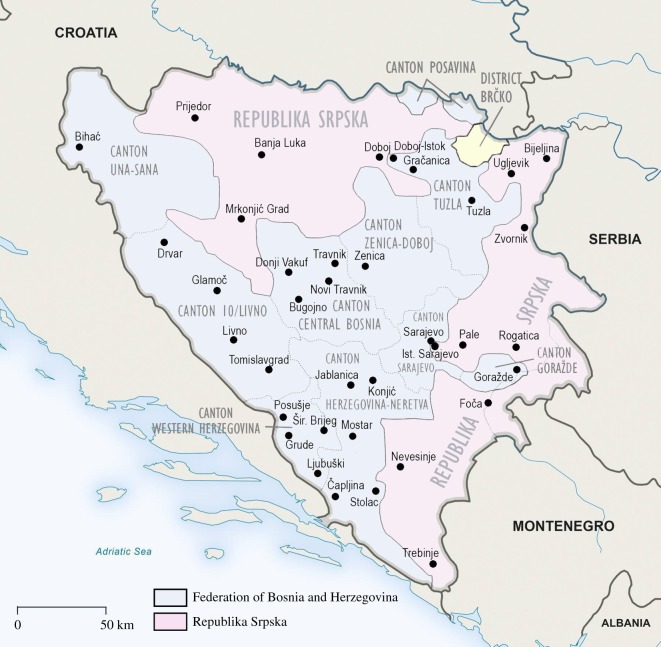
Political division of BiH and localities in which the measurements took place.